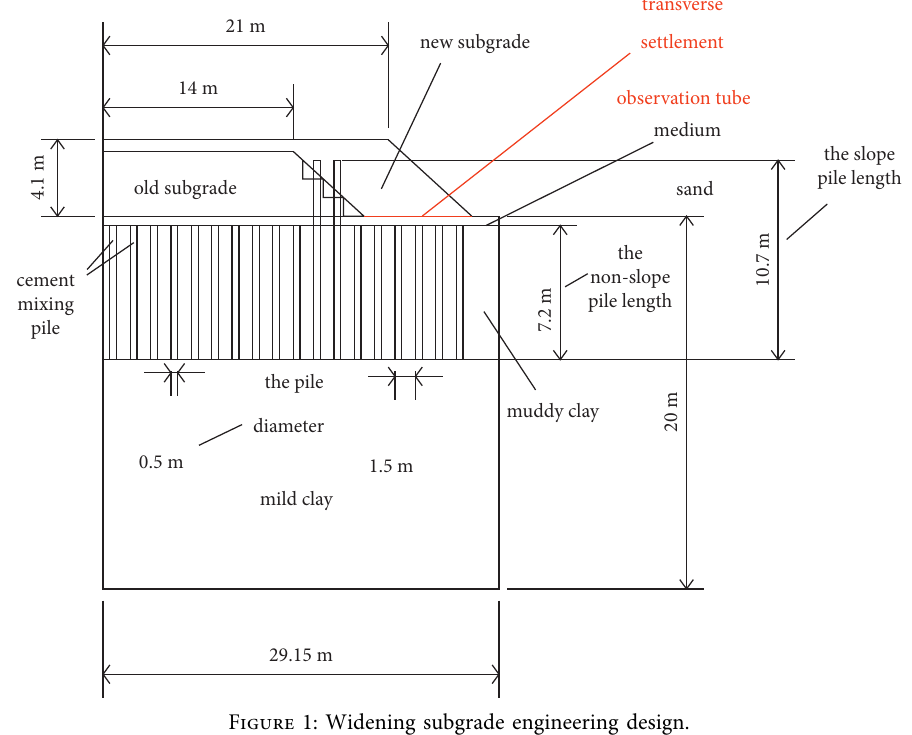
Figure 1: Widening subgrade engineering design.